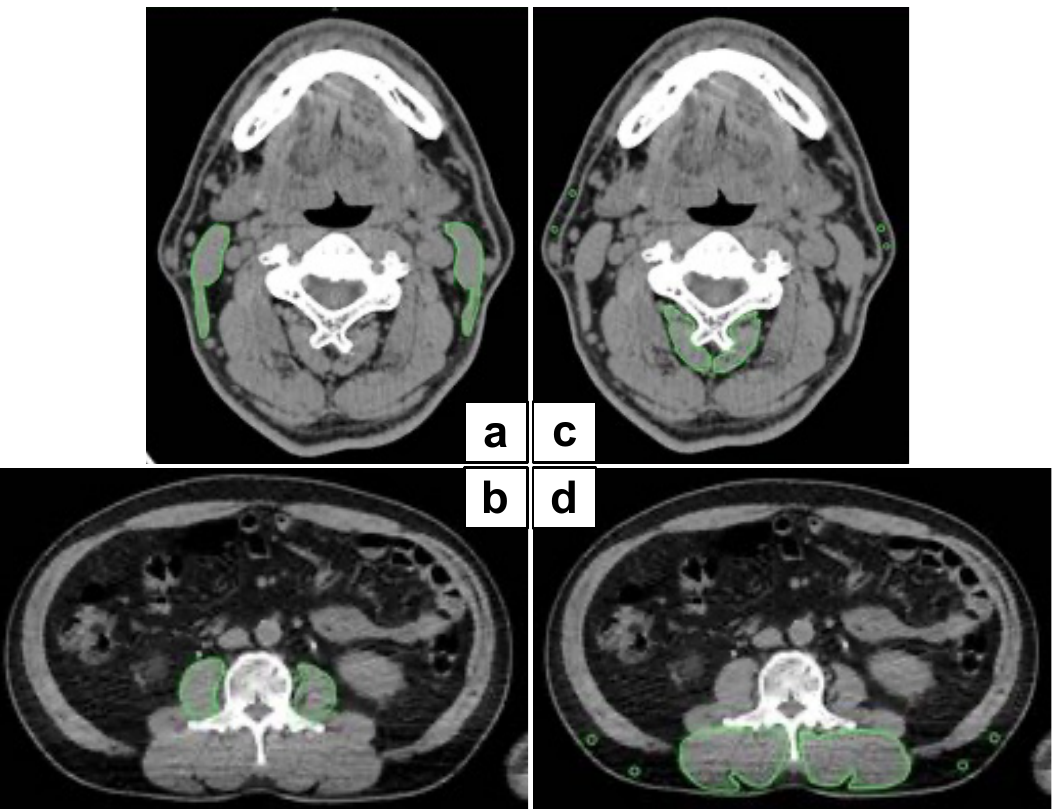
Figure 1. Representative cross-sectional CT images at the C3 and L3 level. ( a , b ) We precisely traced the subfascial outline of the multifidus and sternocleidomastoid muscles. The SCMI and PMI were determined by normalizing the cross-sectional areas to height (cm 2 /m 2 ); ( c , d ) P-IMAC and IMAC were measured by dividing the CT values of bilateral multifidus muscles at the C3 and L3 levels by the CT attenuation values of subcutaneous fat, respectively. CT, computed tomography; SCMI, sternocleidomastoid muscle mass index; PMI, psoas muscle index; P-IMAC, processus spinosus muscle—intramuscular adipose tissue content; IMAC, intramuscular adipose tissue